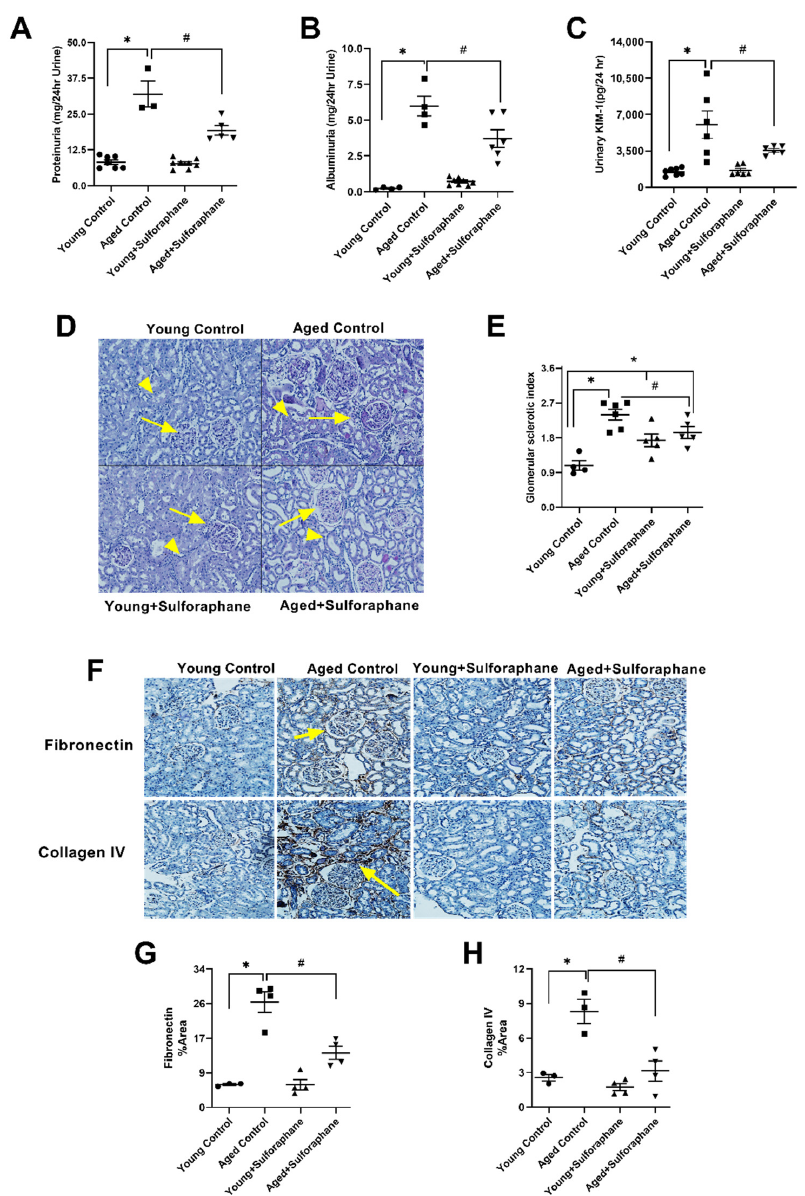
Figure 6. Sulforaphane improves the age-mediated decline in renal function by decreasing the glomerular damage, renal tubular injury and renal fibrosis in kidneys of aged rats. ( A ) Proteinuria. ( B ) Albuminuria. ( C ) Urinary KIM-1 levels. ( D ) Representative images of PAS-stained sections showing glomeruli (arrows) and proximal tubules (arrow heads) in the kidney cortex. ( E ) Bar graph showing glomerular sclerotic index. ( F ) Representative images of fibronectin (top) and collagen IV (bottom) staining (arrows pointing to areas of fibronectin and collagen IV deposition, brown color in glomeruli and interstitial spaces) ( G , H ) Bar graph showing % area of fibronectin and collagen IV staining in young control (young F344 rats kept on tap water); aged control (aged F344 rats kept on tap water); young+sulforaphane (sulforaphane (15 mg/kg body wt/day) in drinking water); aged+sulforaphane. Results are presented as mean ± SEM, n = 3–7 rats. * p < 0.05 significantly different from young control rats; # p < 0.05 significantly different from aged control rats using 1- way ANOVA followed by Newman–Keuls post-hoc test.